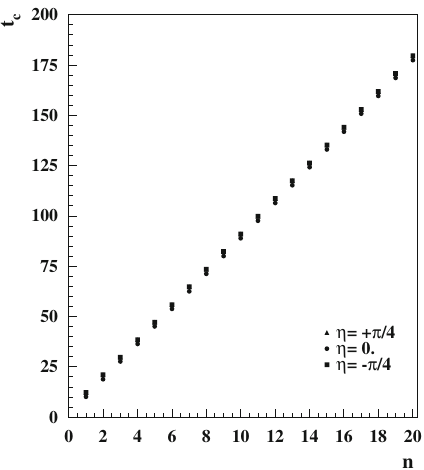
Fig. 3 The critical momenta t c determined in NLO for three fixed non- perturbative phases, η n . t c = ln k 2 c /(cid:3) 2 where a , b are constants independent of ω . This leads to the n ≥ 2, since ν ω ( t 0 ) is less dependent on ω than in LO. Equa- tion (3.2) indicates also that for large n , t c = χ 0 ( 0 )/ should grow almost linearly with n . This is also a feature of the NLO computation; see Fig. 3. The value of t c is related to the value of the critical momenta k c by t c = ln k 2